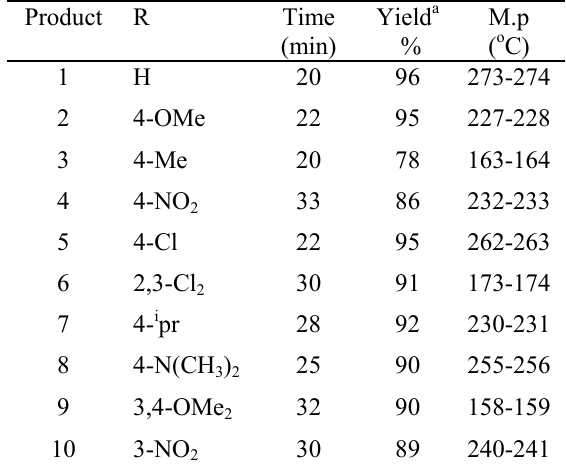
Table 2 . Preparation of 2, 4, 5-trisubstituted